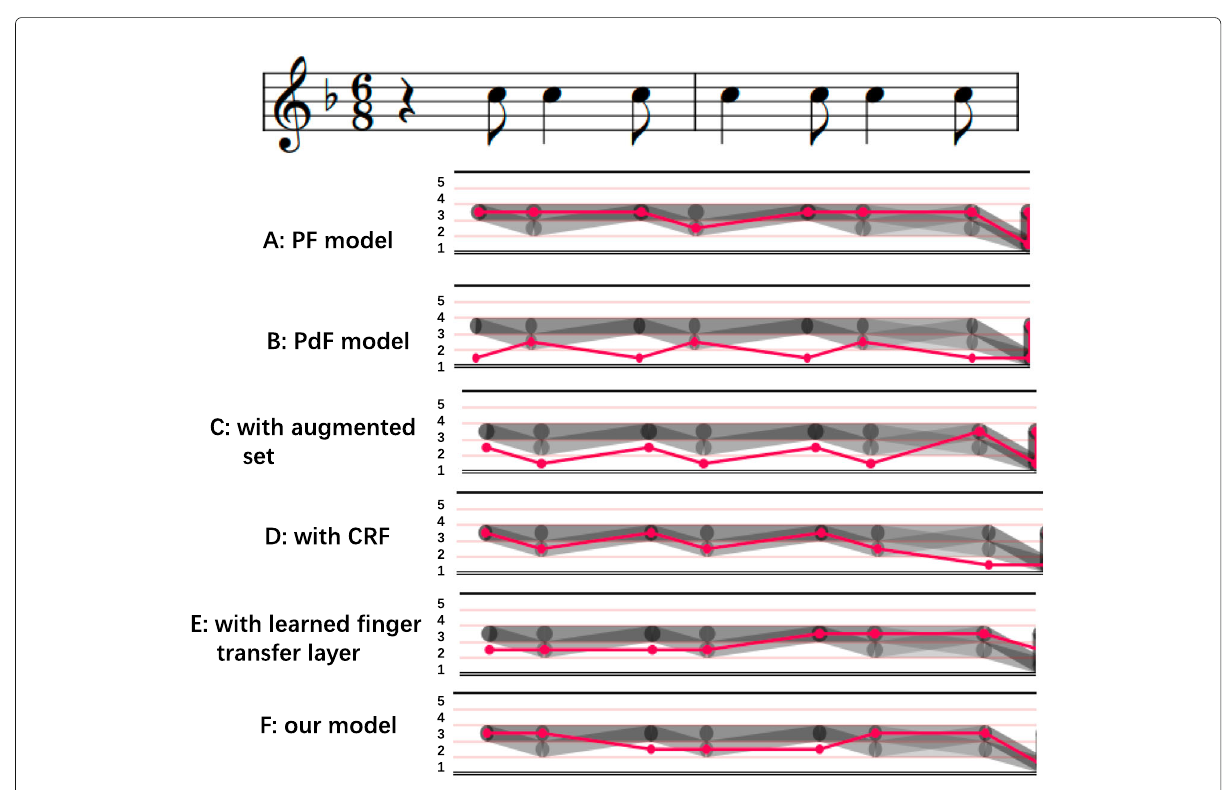
Fig. 10 Annotation result comparison for repeated notes